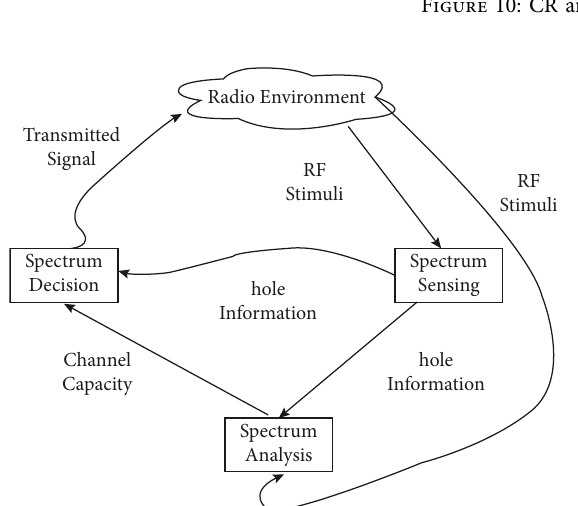
Figure 10: CR architectural framework.